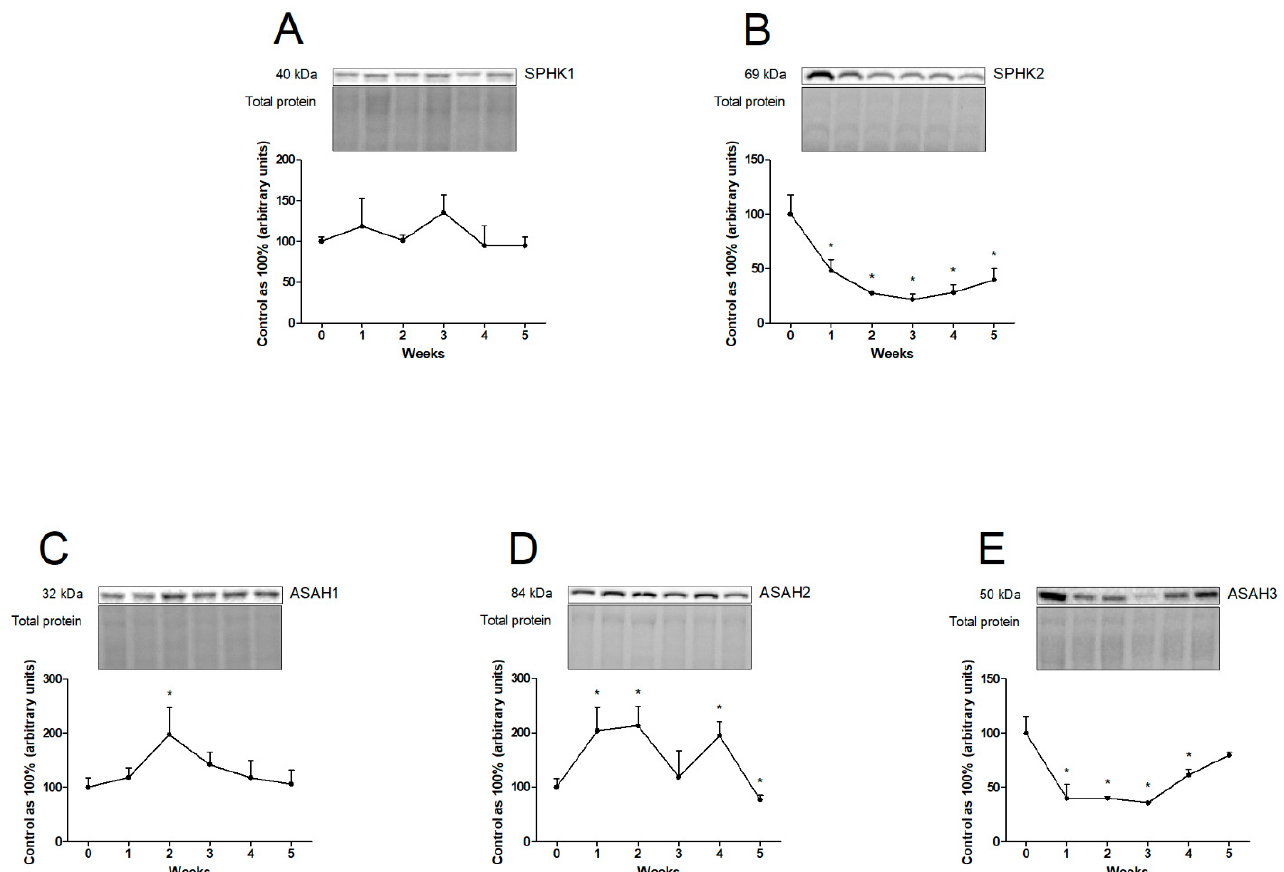
Figure 3. The expression of proteins from the sphingolipid catabolism pathway, i.e., ( A ) sphingosine kinase 1 (SPHK1), ( B ) sphingosine kinase 2 (SPHK2), ( C ) acid ceramidase (ASAH1), ( D ) neutral ceramidase (ASAH2), and ( E ) alkaline ceramidase (ASAH3) in the liver homogenates. The protein expression was measured using the Western blot technique and presented as a percentage difference compared to the control group, which was set as 100%. The data are presented as mean ± SD and based on n = 6 rats per group in each week of the high-fat diet (HFD). * p < 0.05 significant difference vs. control group (0 week).